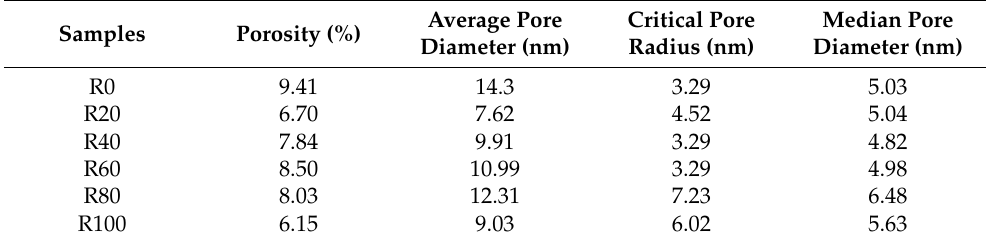
Table 5. MIP results of MUHPC